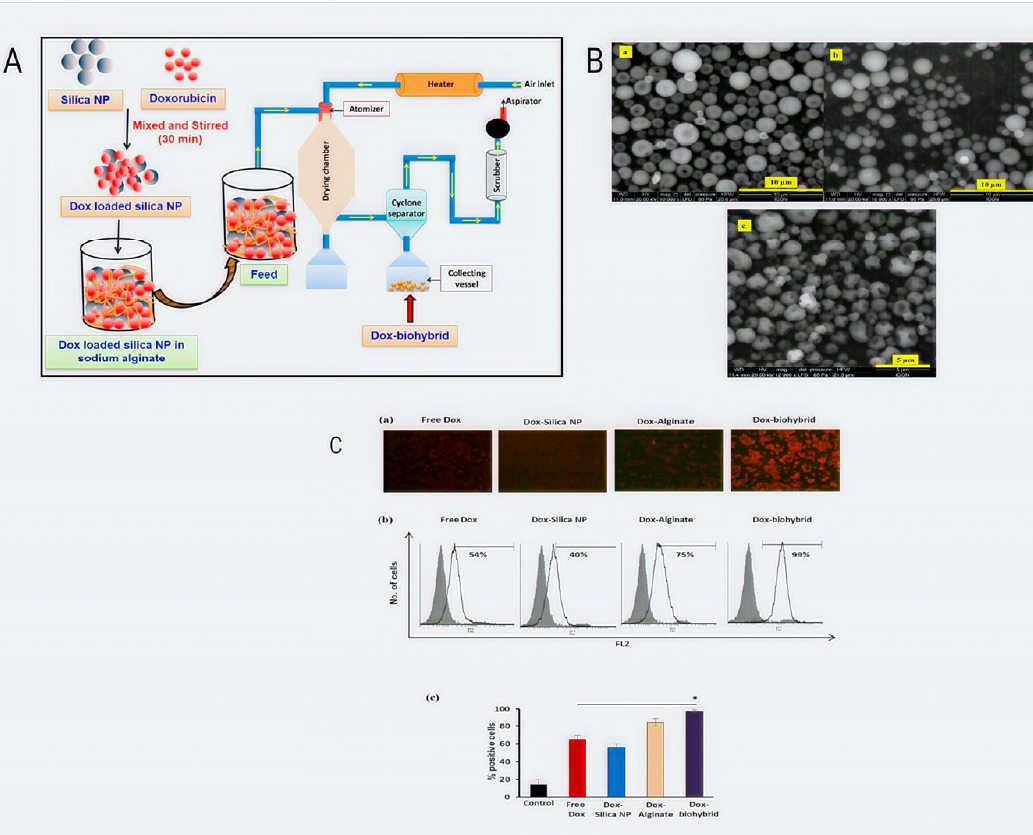
Figure 3. Systematic demonstration of spray drying as a successful method for producing doxoru- bicin drug carriers made of silica nanoparticles and sodium alginate. ( A ) Flowchart of Dox-biohy- brid drug carrier manufacture. ( B ) SEM micrographs of ( a ) 1% Dox-silica nanoparticles (Dox-silica NP), ( b ) 2% Dox-sodium alginate (Dox-sodium alginate), and ( c ) a biohybrid of the two (Dox-bio- hybrid). ( C ) Examination of the cellular uptake of free Dox and encapsulated Dox using fluorescence